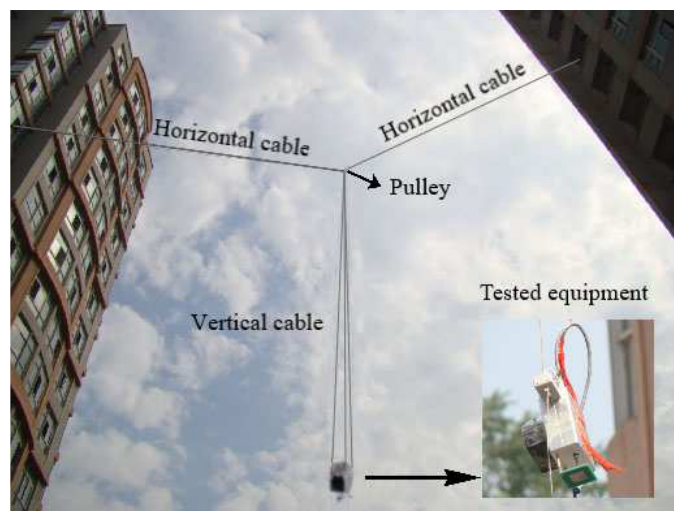
Figure 9. Experimental setup of the ranging system.